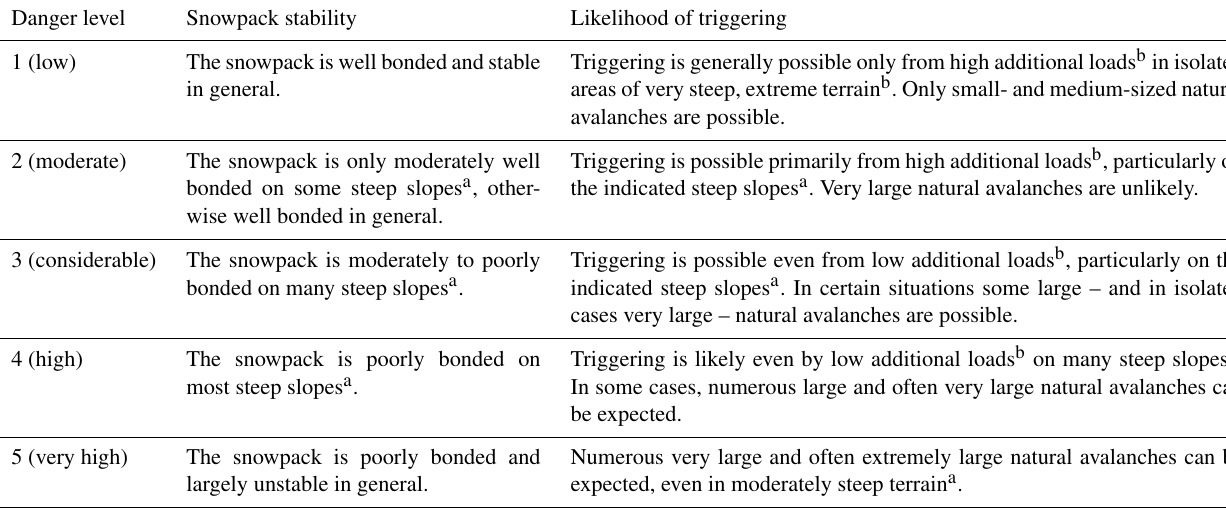
Table 2. European Avalanche Danger Scale (EAWS, 2021a). Danger